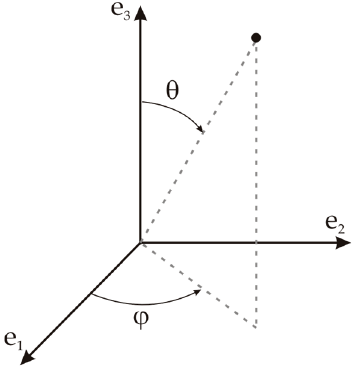
Figure 3. Polar and azimuth angle representation.